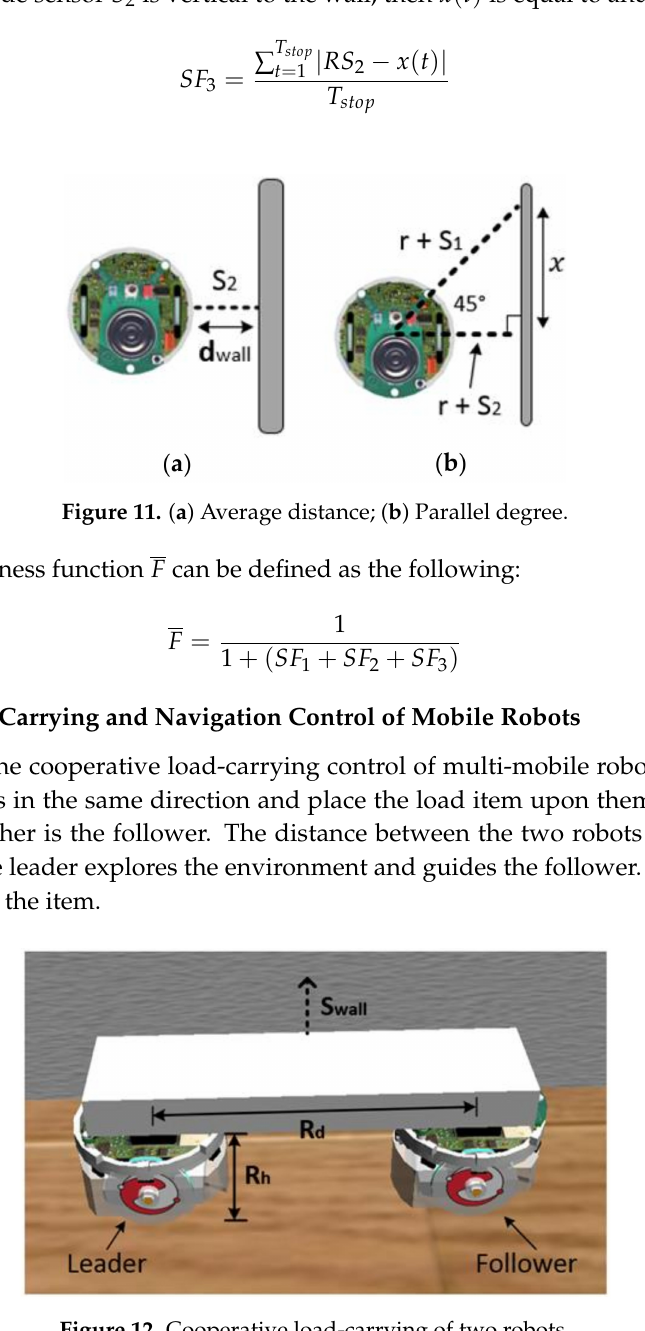
Figure 12. Cooperative load-carrying of two